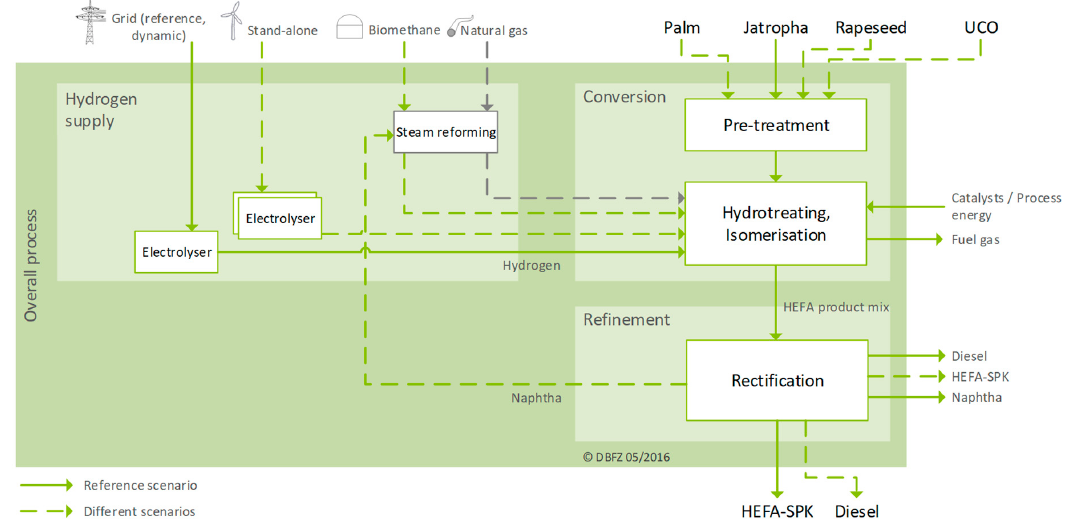
Figure 2. Simplified scheme of PTG-HEFA hybrid refinery and scope.